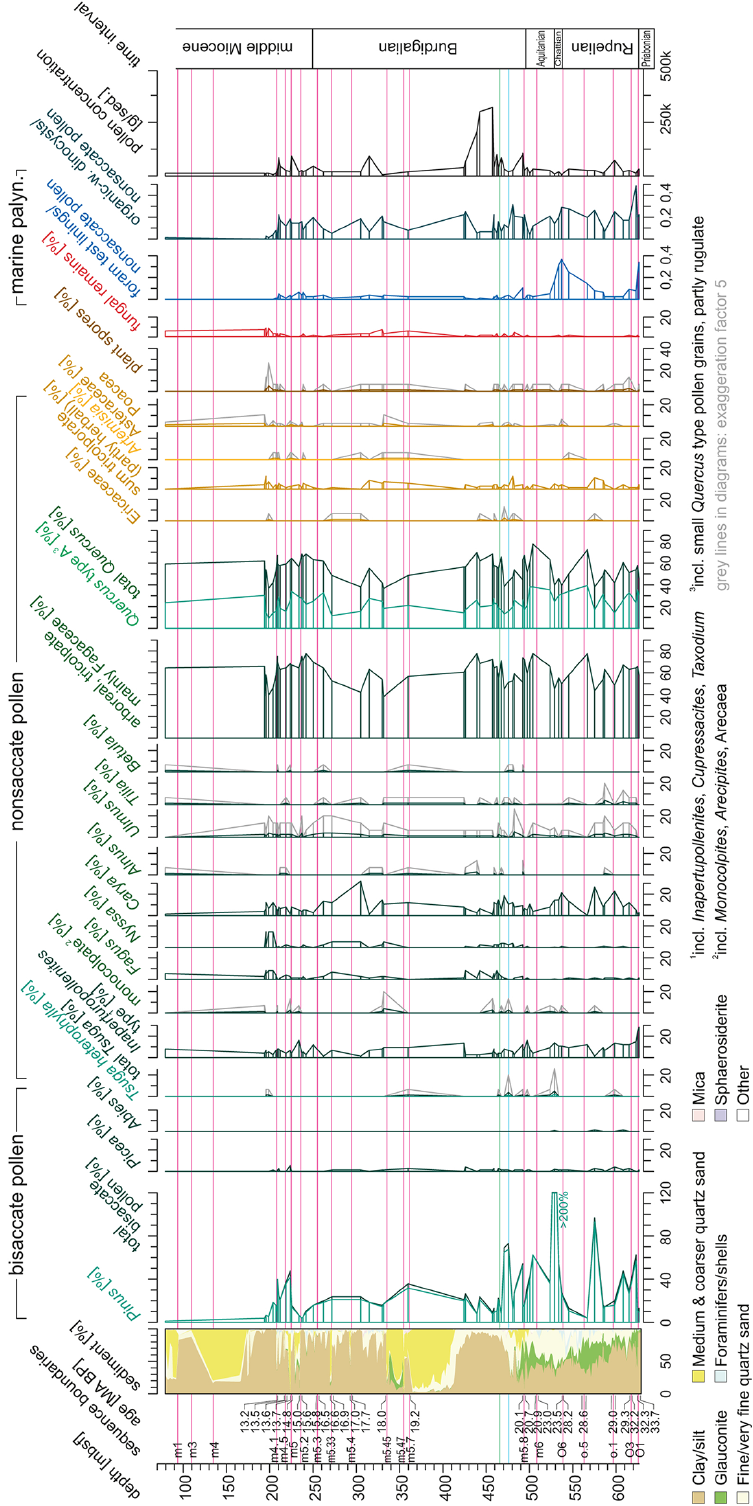
Figure 2. Sedimentological and palynological results for Site M0027. Shown versus depth: lithology; sequence boundaries; selected pollen types, pteridophyte spores and fungal remains (taxa < 1% excluded; percentages are based on the sum of non-saccate pollen); marine palynomorphs (marine palyn.): foraminifer test lining/nonsaccate pollen ratio, organic-walled dinoflagellate cyst/non-saccate pollen ratio; pollen concentration (for some samples, the weight was estimated based on the sample volume), time intervals. For taxa with low occurrences, exaggeration lines ( × 5) are shown in grey. Sequence ages are based on Browning et al.